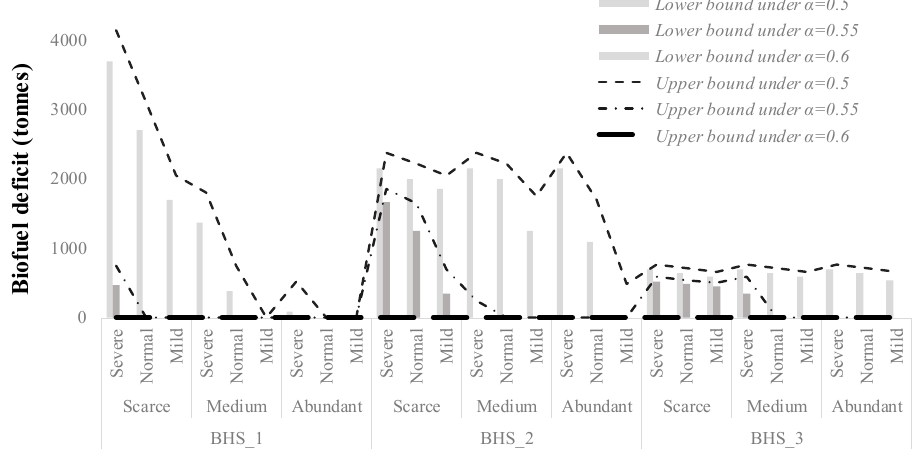
Figure 6. Biofuel deficit variation trend of different BPHSs in Period 2 under various scenario combinations with different α values at Pr = 0.95.